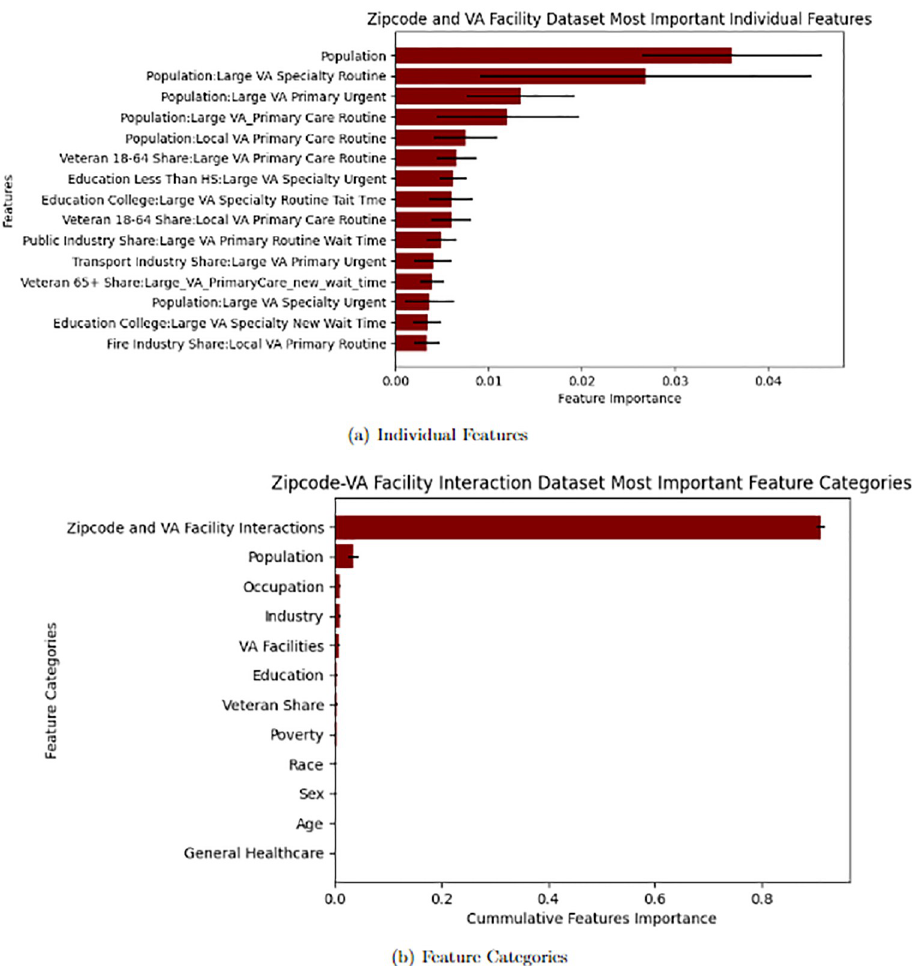
Fig 3. Zipcode-VA facility interaction importance for PPP loans to Veterans. Notes.— Feature Importances are given by an XGBoost model trained on the Zipcode Demographics—VA Facility Interaction Dataset. The dataset includes features pertaining to zipcode level demographic data, access and quality of care of the closest local and large regional VA Medical Centers, and feature columns that interact each feature related to VA facility access and quality of care with each demographic level zipcode feature. The Individual Feature figure plots the 15 most significant individual features by value. The Feature Category figure plots the importance of Feature Categories by the cumulative importance of the features in each category. The error bars represent one standard deviation from the mean importance. A: Individual Features. B: Feature Categories.